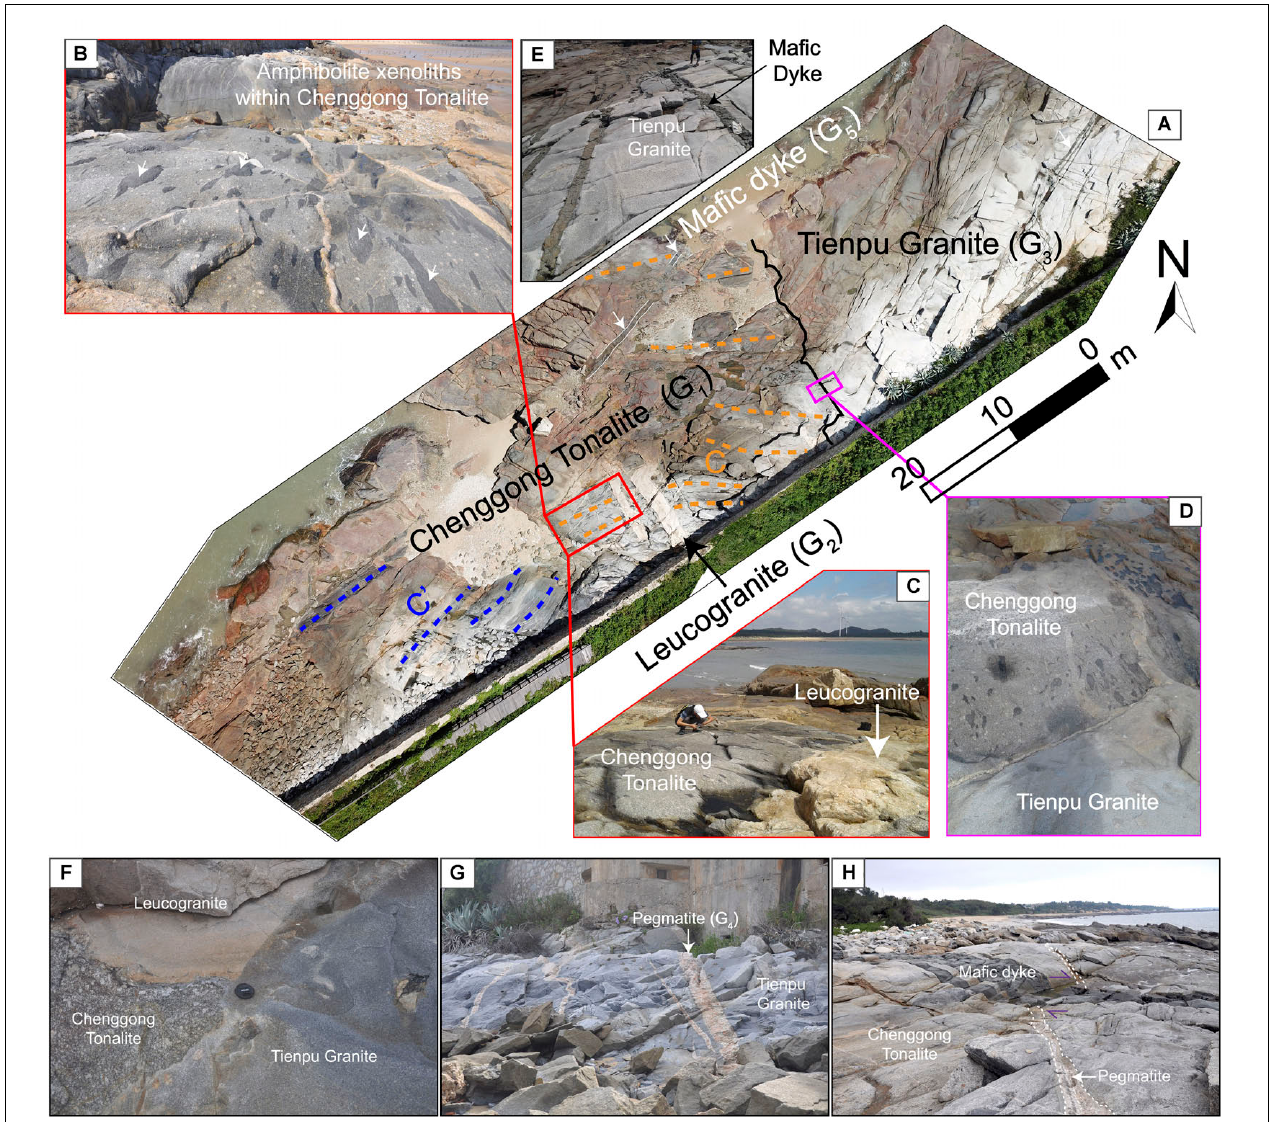
FIGURE 4 | Aerial and outcrop photos of Tien Pu (TP) region showing the crosscutting relationships of different lithology units (G 1 –G 5 ). (A) Aerial photo of part of the TP region with sketched D 3 C/C’ fabrics and labeled lithology units of Chenggong Tonalite (G 1 ), leucogranite (G 2 ), Tienpu Granite (G 3 ), and mafic dykes (G 5 ). (B) Deformed Chenggong Tonalite with aligned amphibolite schist xenoliths that are heterogeneously deformed and sheared. (C) Deformed Chenggong Tonalite intruded by post-D 3 leucogranite. (D) Deformed Chenggong Tonalite intruded by undeformed Tienpu Granite. (E) Undeformed Tienpu Granite truncated by the mafic dike. (F) Chenggong Tonalite intruded by leucogranite, both of which are truncated by Tienpu Granite. (G) Tienpu Granite intruded by pegmatites (G 4 ). (H) Pegmatites crosscutted and dextrally displaced by the mafic